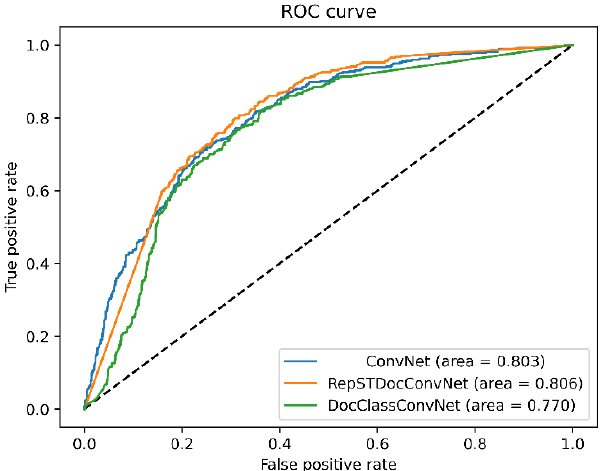
Figure 7. Receiver operating characteristic (ROC) curves of models classifying representative spatio- temporal documents using ConvNet, DocClass_ConvNet_Mod and RepSTDoc_ConvNet.